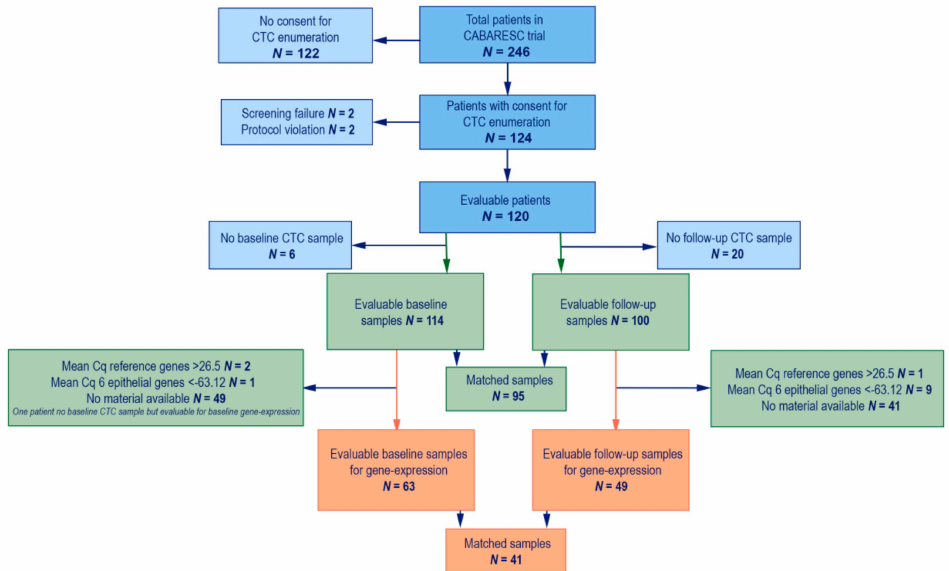
Figure 3. Patient inclusion. Flowchart of patient inclusion. In blue all patients who are included in the CABARESC study and the side CTC enumeration study. In green the patients included for this manuscript with available CTC enumeration. In Orange the patients included for this manuscript with available gene expression